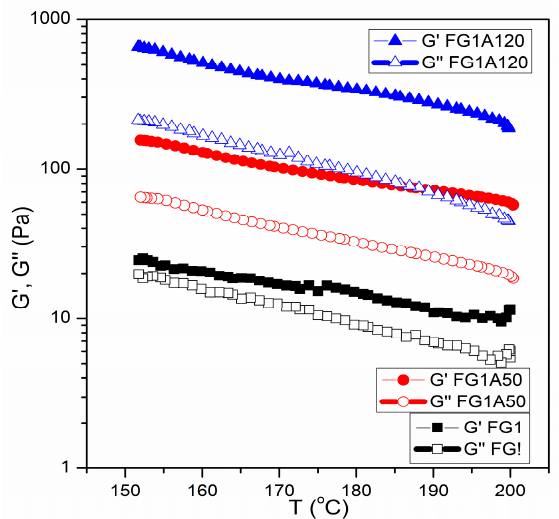
Figure 7. Storage (G’) and loss (G”) modulus of FG1, FG1A50, and FG1A120 at various temperatures, and angular frequency ( ω ) of 1 rad/s.